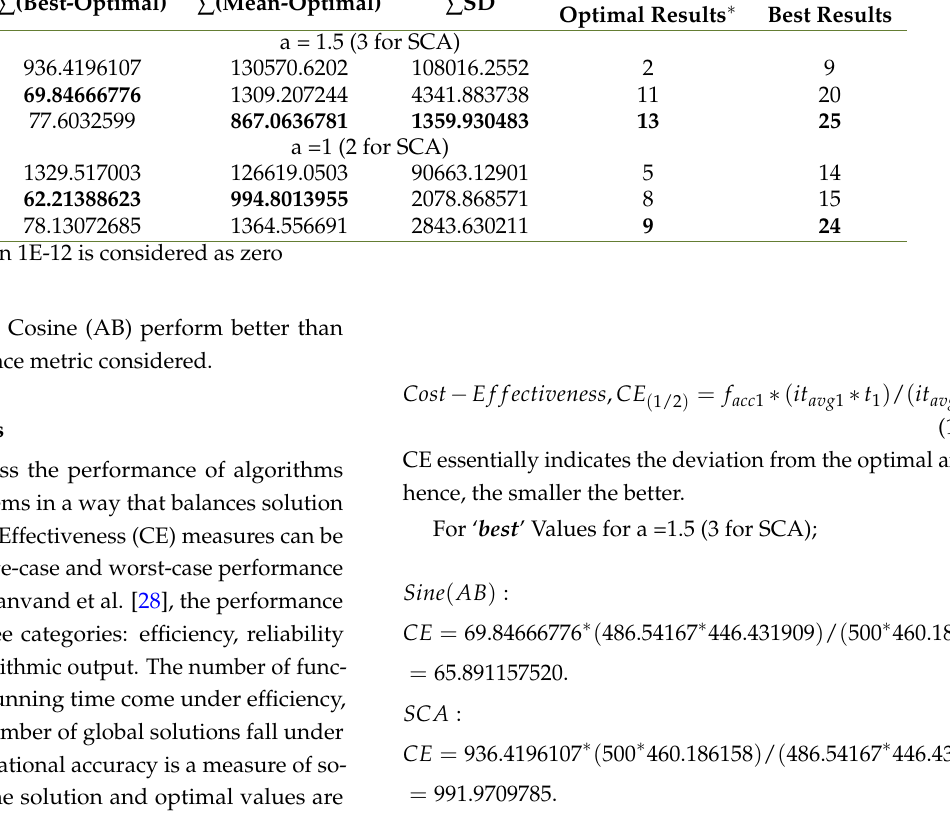
Table 9. Summary of Performance of Algorithms (40 Benchmark Functions)